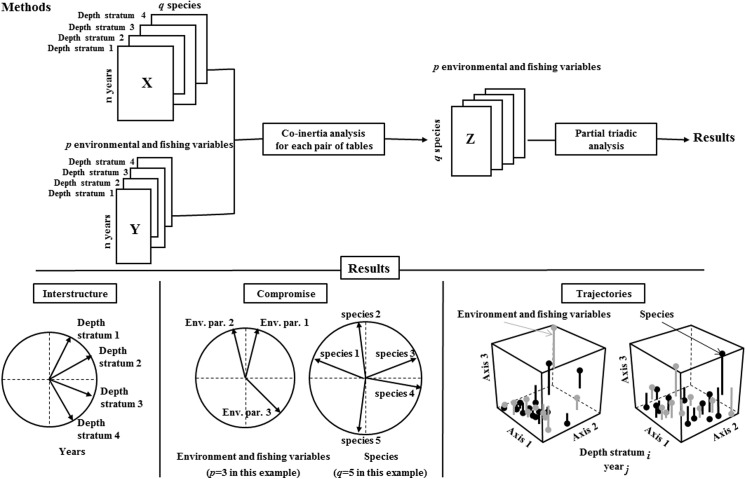
STATICO flow chart, the data structure is a sequence of n pairs of ecological tables.The X and Y are respectively the pairs of tables (species and environment-fishing). The Z is cross-table, q number of species, p number of variables environment-fishing. 1- Principal Component Analysis executed on each table (PCA) log transformed of species abundance and environment-fishing. 2- Co-inertia analyses allowing the link between the pairs of PCA, producing a sequence of cross-tables. 3- Partial Triadic Analysis (PTA) is used to analyze this series.